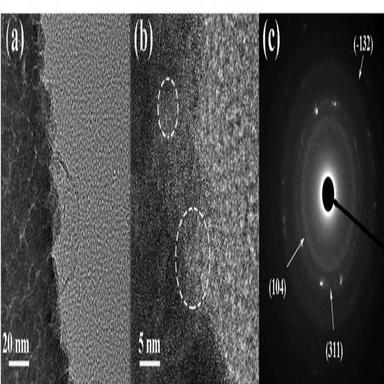
TEM image of a chromium oxide thin film obtained under an oxygen partial pressure of 66.7 %. a) and b) TEM Images at Different Magnifications, c) Selected Area Electron Diffraction (SAED) Pattern.